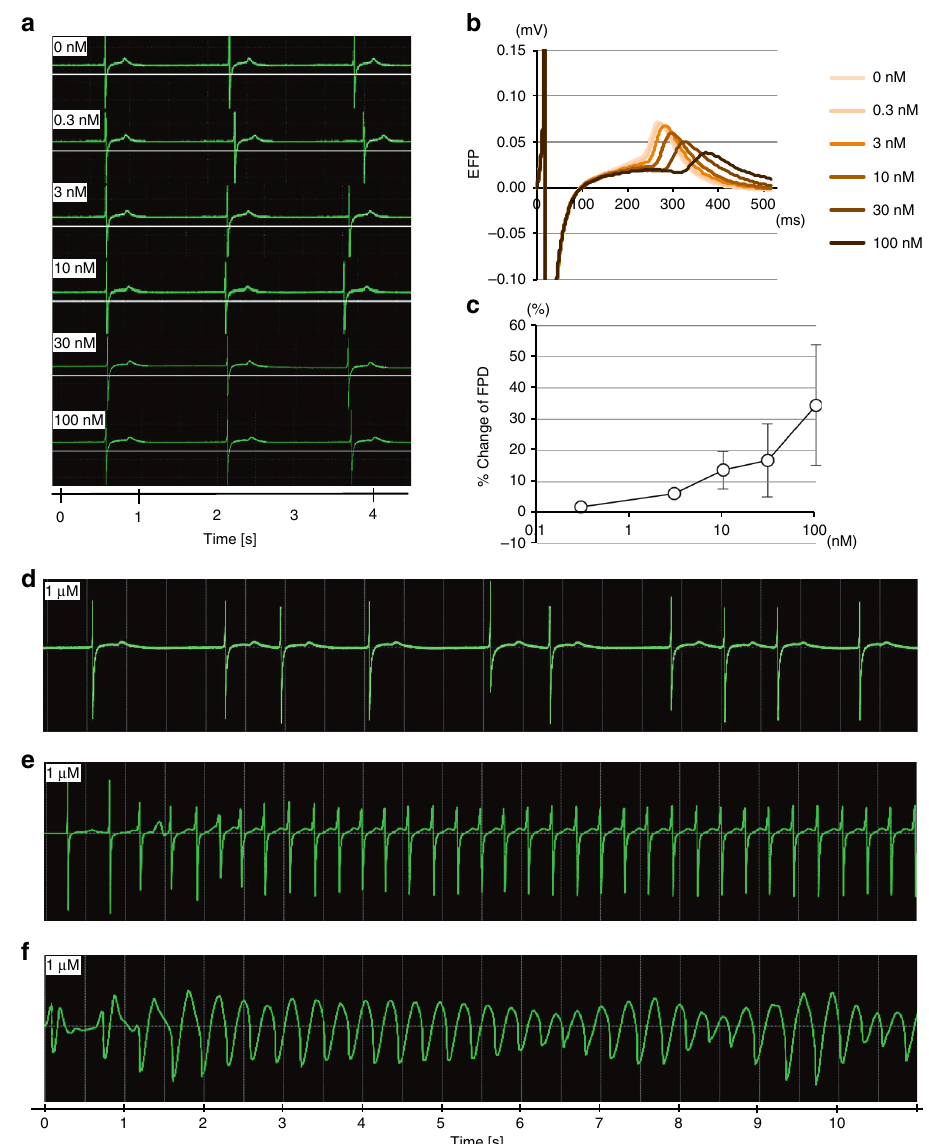
Fig. 2 Drug-induced TdP-like EFP waveforms in CTSs. a EFP waveforms in response to E-4031 (IKr channel blocker). b Overlaid EFP waveforms at each E-4031 dosage. FPD prolongation is observed. c Relative change in FPD after E-4031 treatment ( ± s.d., n = 4). d Representative transient change of EFP waveforms at an early stage after E-4031 treatment (1 μ M). e Representative monomorphic ventricular tachycardia-like waveform after E-4031 treatment (1 μ M). f Representative polymorphic ventricular tachycardia TdP-like waveform after E-4031 treatment (1 μ